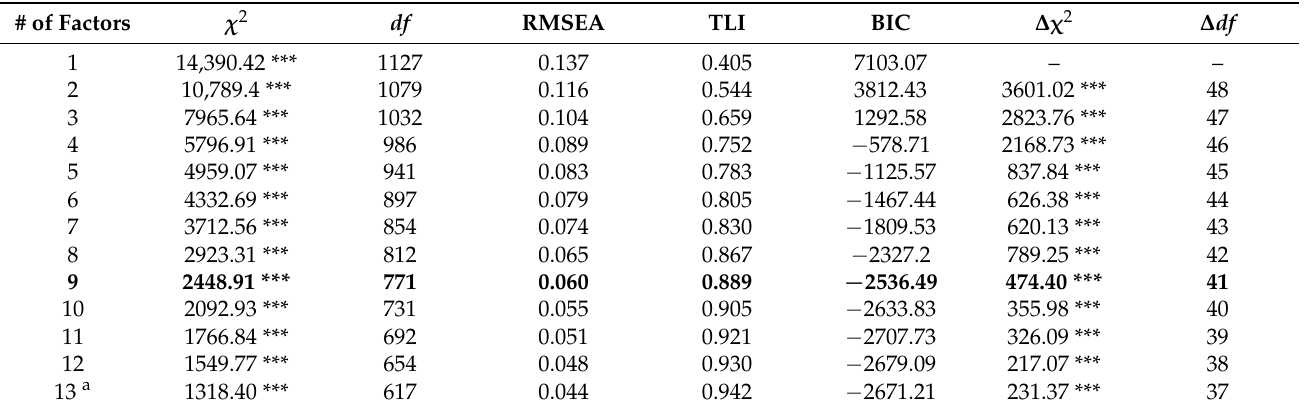
Factor loadings for the final nine factors are presented in Table 4, and represent: (1) Fear of loss of sexual pleasure/attractiveness (SEX), (2) Fear of pain from a vaginal birth (PAIN), (3) Fear of medical interventions (INT), (4) Fear of embarrassment (SHY), (5) Fear of harm to baby (HARM), (6) Fear of caesarean birth (CS), (7) Fear of mum or baby dying (DEATH), (8) Fear of insufficient pain medication (MEDS), and (9) Fear of body damage from a vaginal birth (DAMAGE). Correlations between the nine CFQ factors ranged from weak (r = − 0.01) to strong (r = 0.84), with approximately one third equal to or greater than 0.50 (see Table 5 for details). Correlations at or above 0.50 were for: Fear of loss of sexual pleasure/attractiveness with Fear of pain from a vaginal birth, Fear of embarrassment, Fear of insufficient pain medication and Fear of body damage from a vaginal birth; Fear of pain from a vaginal birth with Fear of insufficient pain medication and Fear of body damage from a vaginal birth; Fear of medical interventions with Fear of caesarean birth; Fear of embarrassment with Fear of body damage from a vaginal birth, and Fear of harm to baby with Fear of mom or baby dying and Fear of body damage from a vaginal